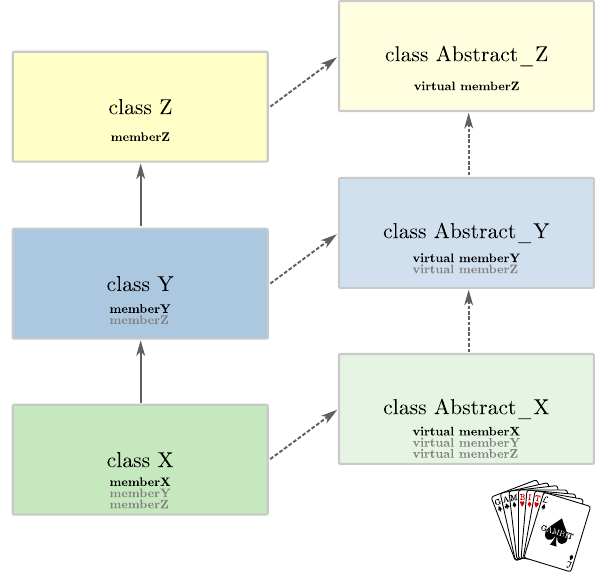
Fig. 3 The basic class ‘ladder’ pattern generated by BOSS in order to allow runtime loading of classes X , Y and Z , where Z is the parent of Y , which is in turn the parent of X . The original class hierarchy is mirrored by the abstract parent classes generated by BOSS . Virtual inheritance, illustrated here by dashed arrows, is used to avoid ambiguities. Member functions in the original classes are matched by pure virtual member